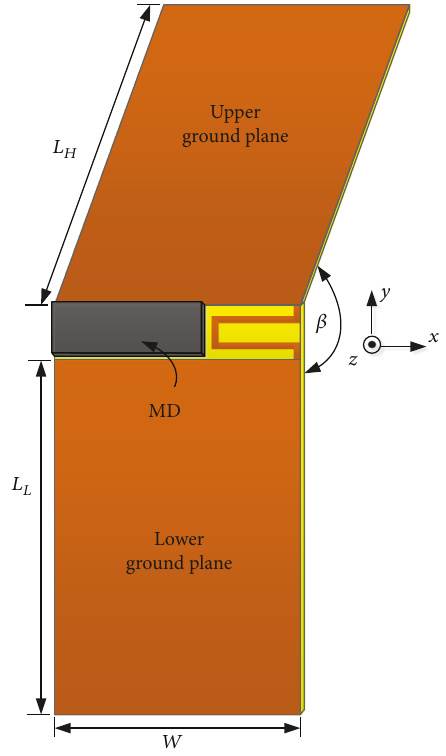
Figure 4: The geometry of the proposed meander line antenna (MLA) with MD (not to scale).